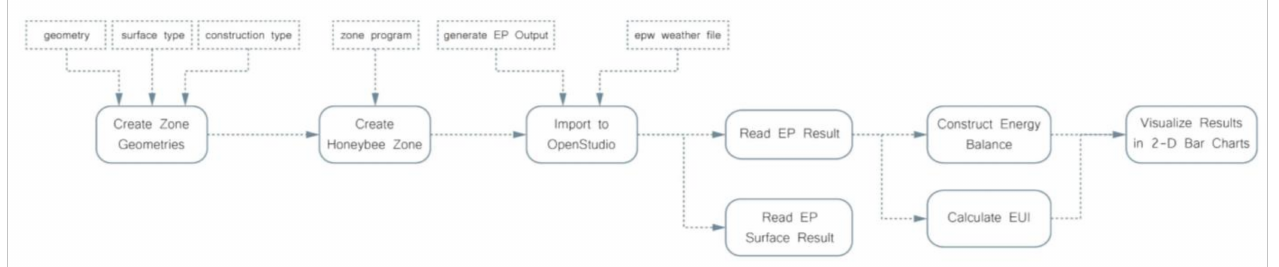
Figure 11. Flowchart of the energy use intensity calculation